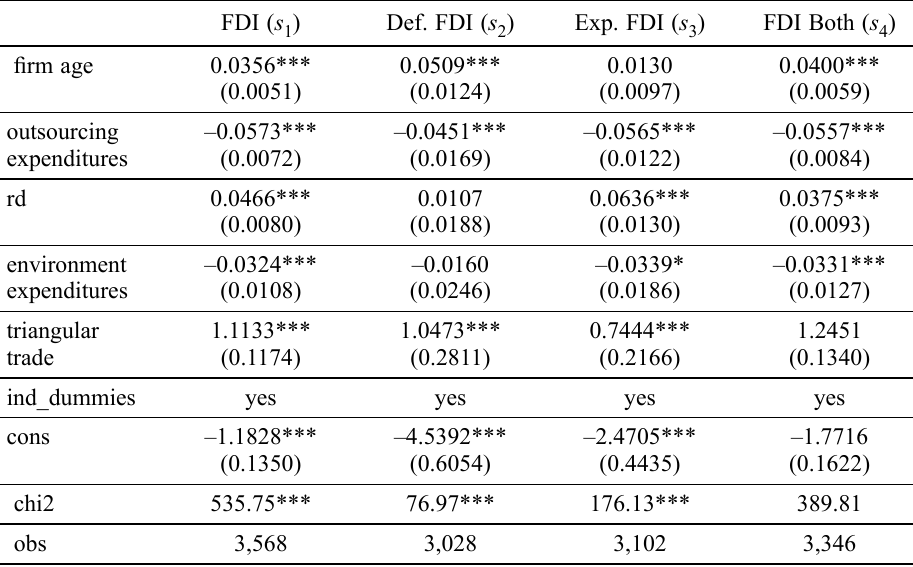
Table 3. Estimation results from logistic